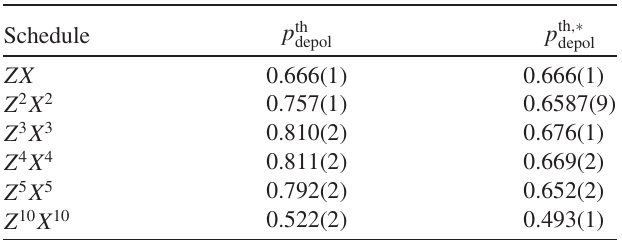
TABLE V. Thresholds (in %) for the subsystem toric code for some balanced homogeneous schedules under the circuit-level depolarizing noise model, each computed using the critical exponent method of Ref. [61] to analyze results from Monte Carlo simulations using subsystem toric codes with distances L ¼ 26 , 30, 34, 38, 42, 46. Numbers in brackets are the 1 σ uncertainties in the last digit. For each threshold, we keep the number of syndrome extraction rounds constant for all codes, always using at least 92 rounds to ensure boundary effects (in time) are small even for the largest codes. For the column with an asterisk, gauge fixing is not used when